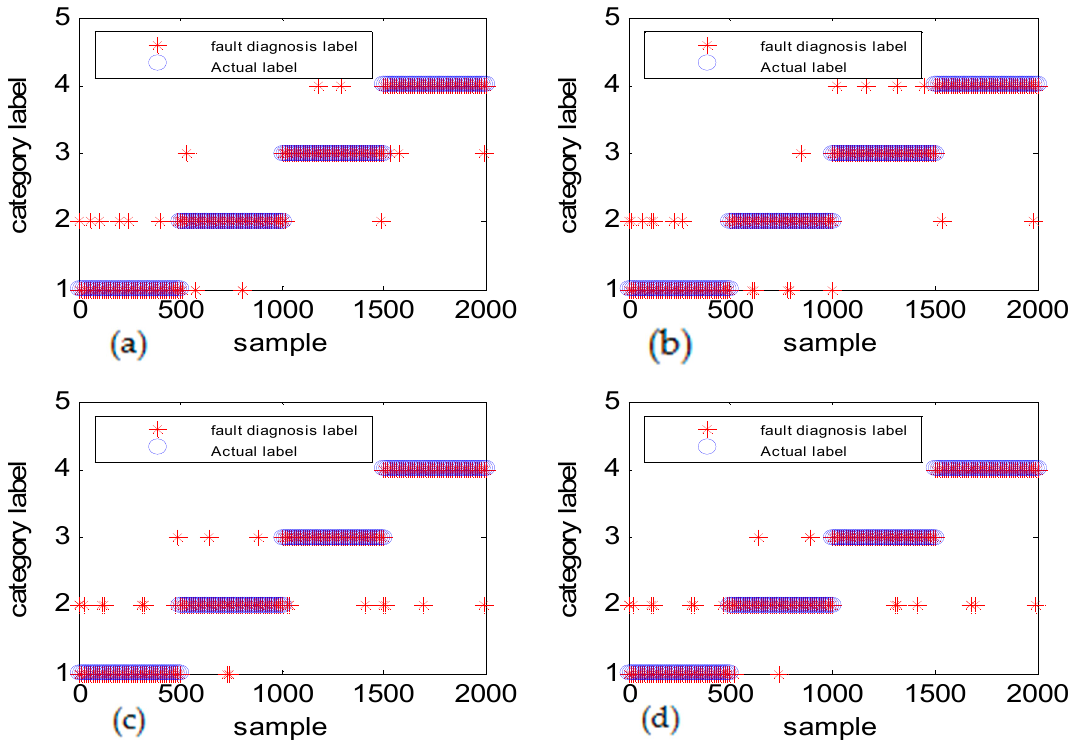
Figure 22. DNN diagnostic results using FFT as a preprocessing tool. ( a ) DGFFDNN, ( b ) DNN, ( c ) DGFFBP, and ( d ) BP.